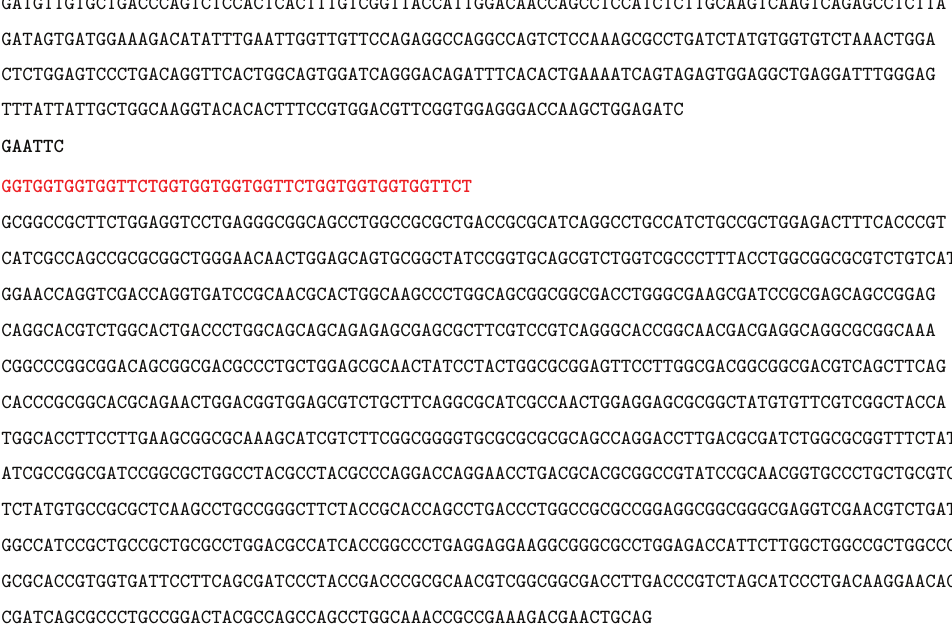
Figure 3: Sequence of immunotoxin. Black bold basic group represents restriction enzyme recognition site; red bold basic group represents the linker